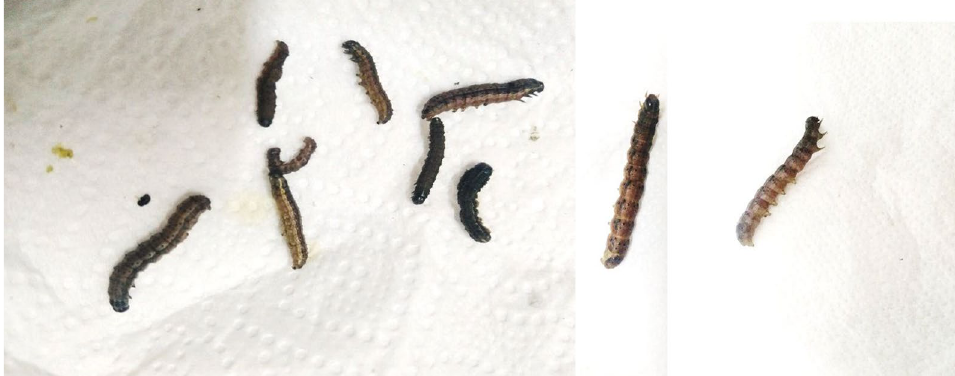
Fig. 5 Mortality of different larval instars of Spodoptera frugiperda after the application of EPNs, Heterorhabditis